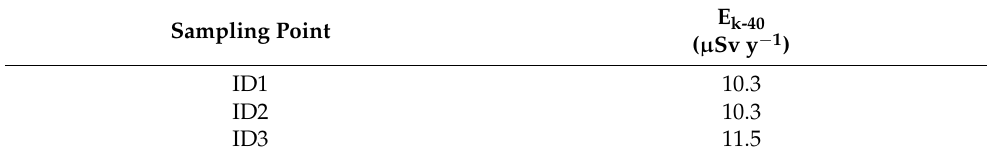
Table 4. The total effective dose due to sample ingestion by adult members of the